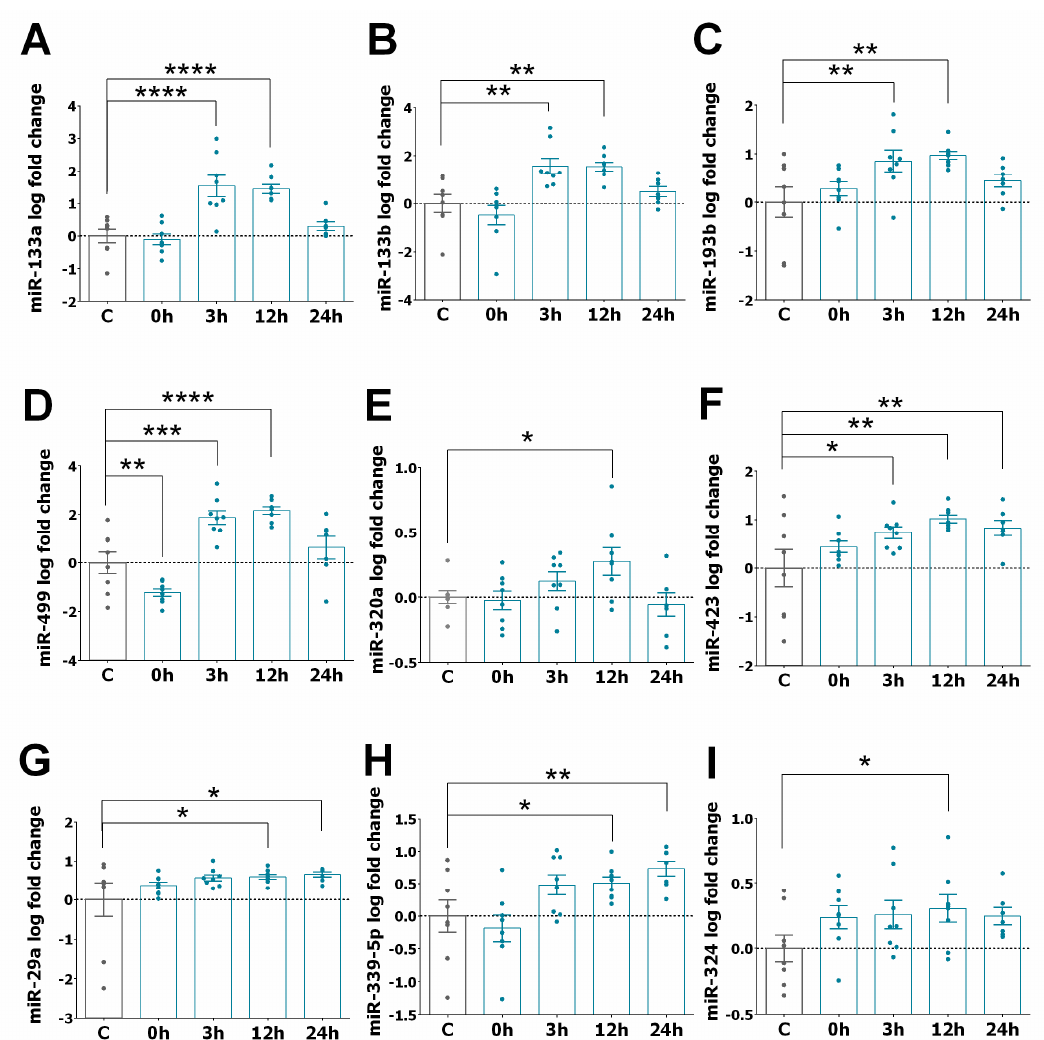
Figure 2. Upregulation of circulating miRNAs in the serum of post-STEMI patients. ( A–I ) Graphs showing the kinetics of miRNAs in serum samples of STEMI patients ( n = 8) before PPCI (0 h) and 3, 12, and 24 h after the PPCI procedure. Bar graphs show changes in the expression of miR-133a ( A ), miR-133b ( B ), miR-193b ( C ), miR-499 ( D ), miR-320a ( E ), miR-423 ( F ), miR-29a ( G ), miR-339-5p ( H ) , and miR-324 ( I ) in patients after PPCI compared to control patients ( n = 8). Values represent the fold changes (in logarithmic scale) for each miRNA relative to controls. Data are presented as the means ± SEM. Significance is indicated by (*) for p < 0.05, (**) for p < 0.01, (***) for p < 0.001), and (****) for p < 0.0001. Ordinary one-way ANOVA with multiples comparisons using T-test without correction (Fisher’s LSD test) was performed.